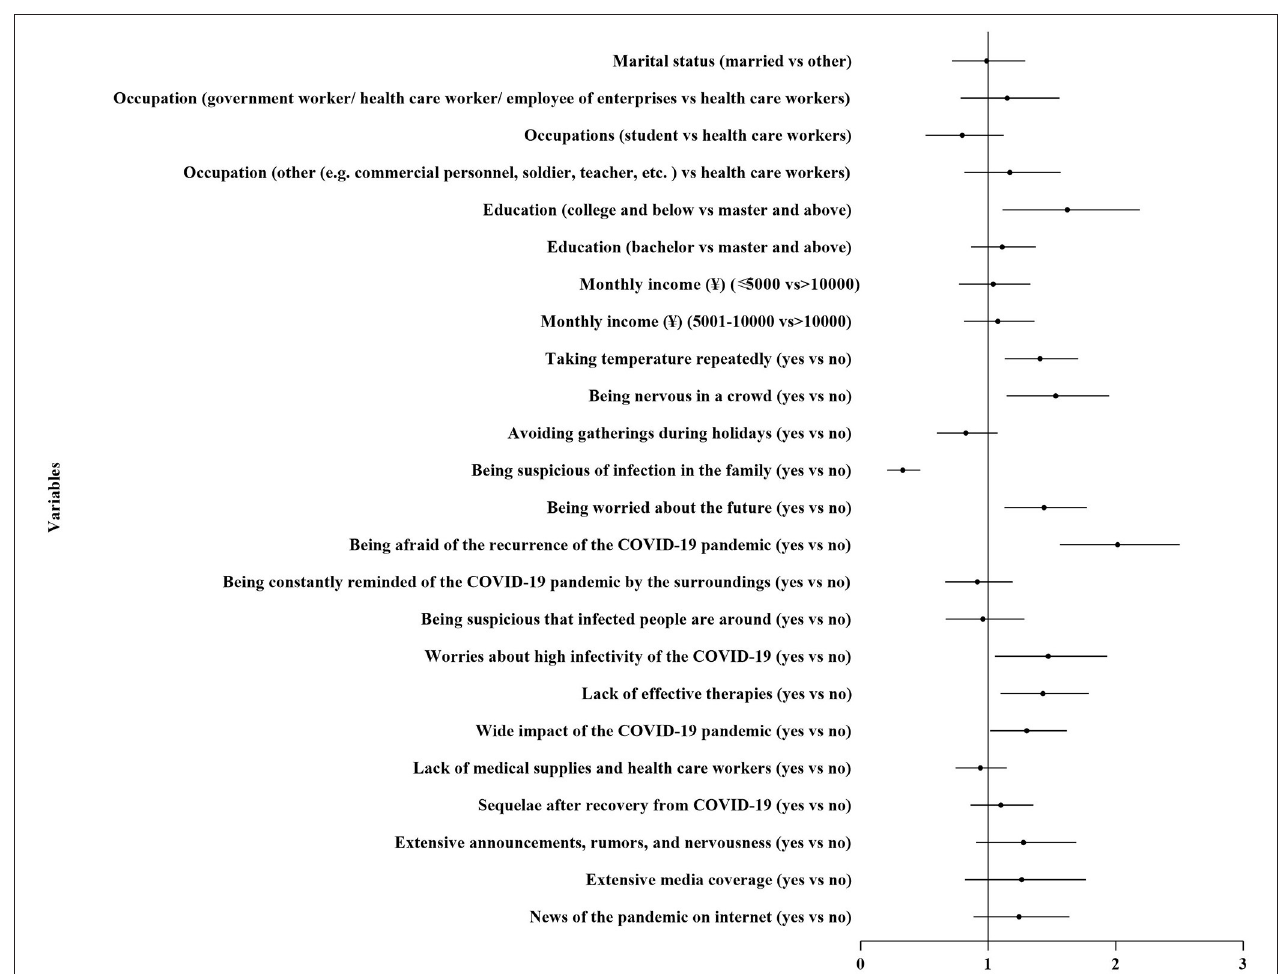
FIGURE 5 | The forest plot of the risk factors and the associate factors of public panic.